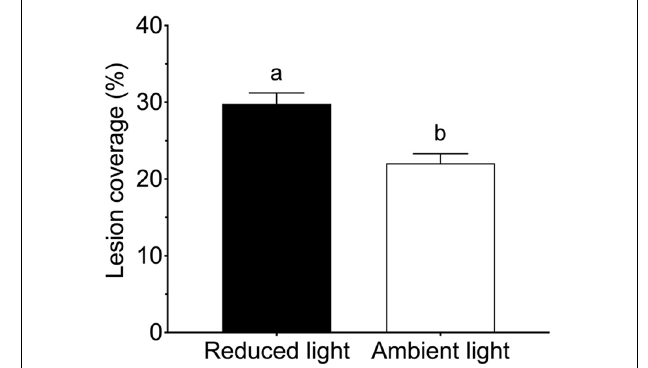
FIGURE 2 | Lesion coverage (% of total area) following inoculation by Labyrinthula zosterae on Zostera marina shoots exposed to ambient and reduced light intensity. Different letters above bars indicate significant differences between treatments based on the Student–Newman–Keuls test ( P < 0.05). Only significant results (see Table 2 ) are included in the figure and not all interactions. The non-significant treatments are therefore pooled giving a higher replication than 20 replicates per treatment. Error bars show standard error, n = 80.